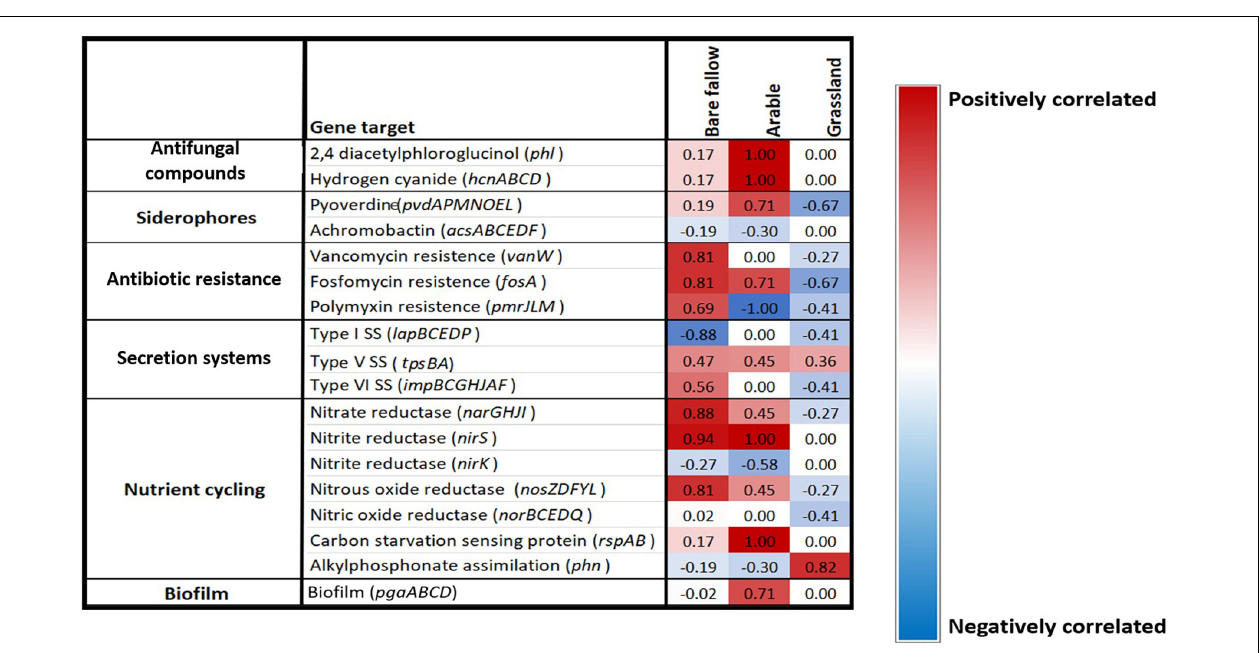
FIGURE 7 | Gene presence/absence correlation coefficient analysis. Spearman’s rank correlation coefficients between the presence or absence of a selection of PGPR traits correlated against the presence of the acdS gene in bacterial isolates from three distinct land managements. The scale range is from dark blue (highly negatively correlated) to bright red (highly positively correlated), light colors represent low